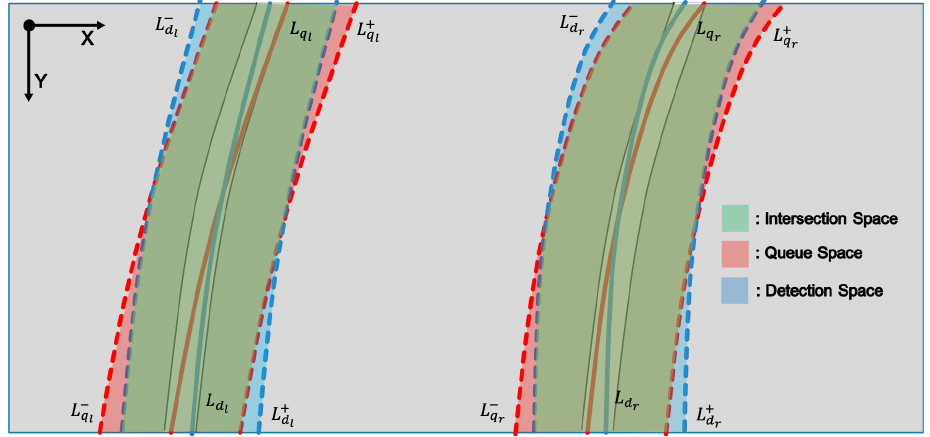
Figure 9. Lane IoU